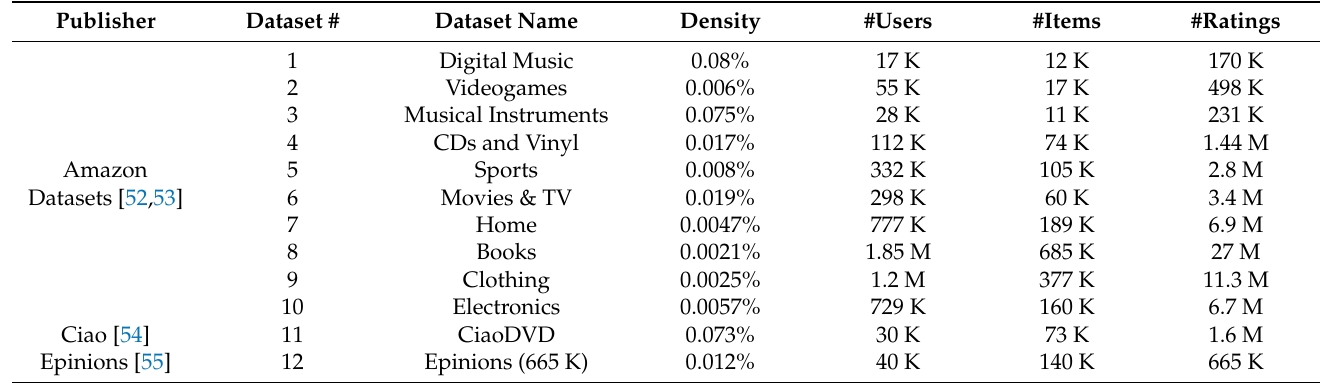
Table 1. Dataset